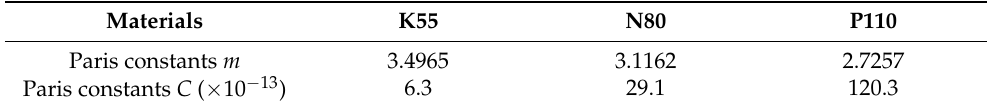
Table 4. Material constants m and C .